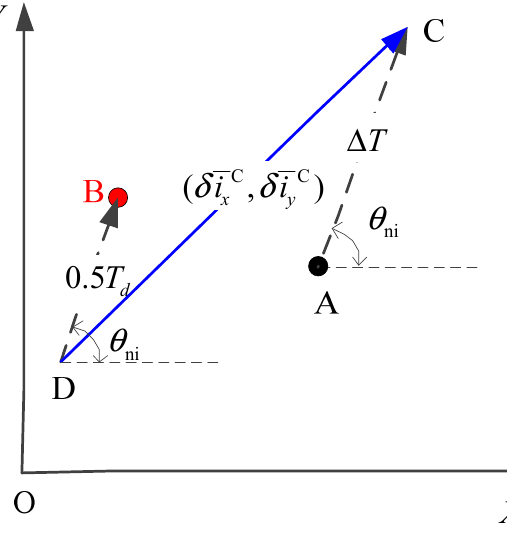
Figure 13. The orbital inclination vector for control.